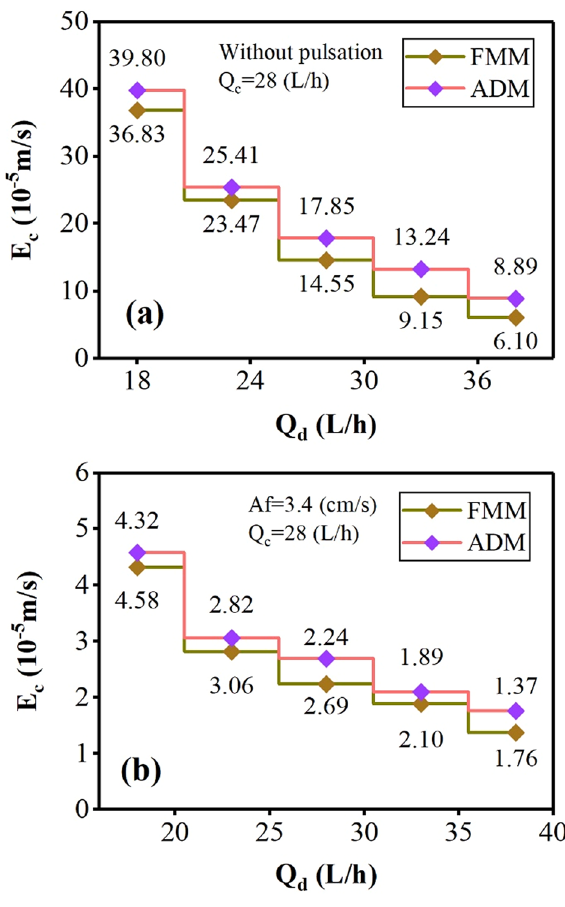
Figure 9. The effect of organic phase flow rate on the continuous phase axial dispersion coefficient ( a ) without pulsation, ( b ) Af = 3.4